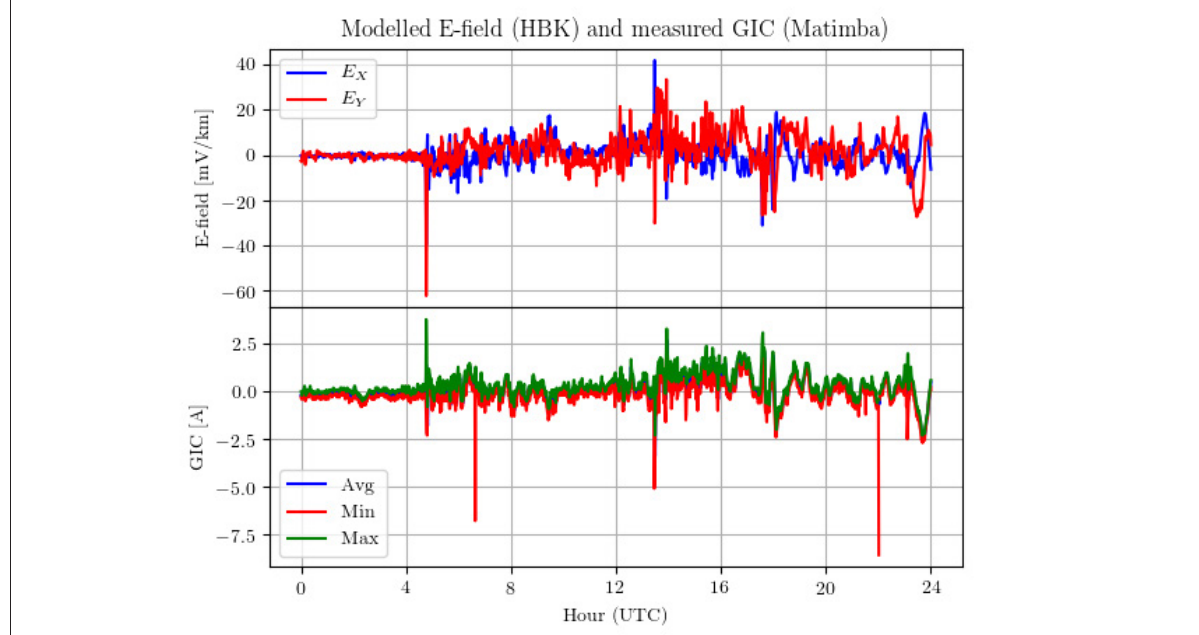
and E are the X and Y components of the electric field, X Y